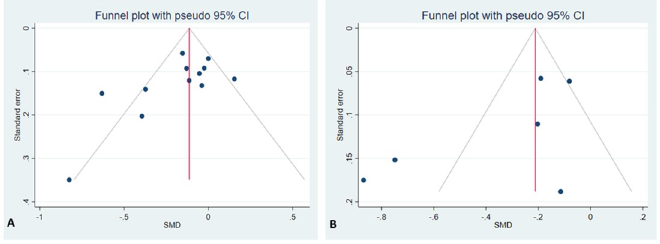
Fig 4. Funnel plots for assessment of publication bias for studies reporting (A) dmfs (B)